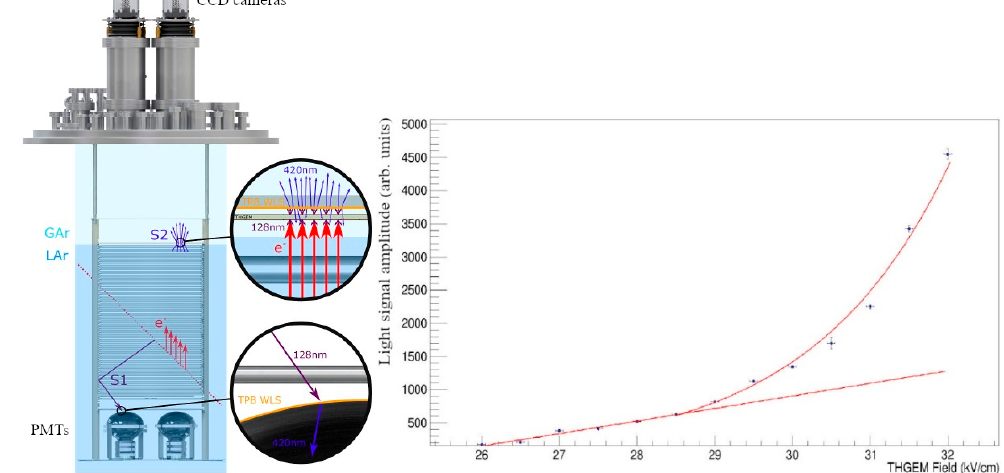
Figure 24. Left: concept of combined charge/light signal amplification in two-phase detector [61], using avalanche scintillations in combined THGEM/CCD-camera multiplier [60], in the most elaborated way realized in [61], with 54 × 54 cm 2 active area and overall liquid Ar mass of 1 t. Right: light signal amplitude on the CCD-cameras as a function of the nominal electric field in THGEM holes (data points) [61].